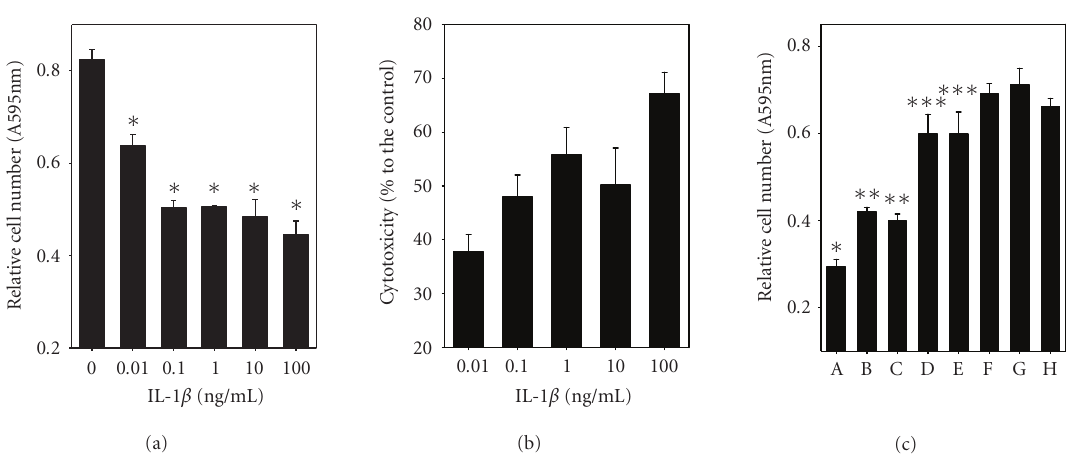
Figure 1: IL-1 inhibition of JAR proliferation. (a) JAR cells were cultured in the presence of increasing concentrations of IL-1 for 72 hours. Relative cell numbers were measured by MTT assay. (b) LDH release assay was performed for cytotoxicity of IL-1. (c) JAR trophoblasts were cultured for 72 hours with either IL-1 (50ng/mL) alone (A), IL-1 with anti- IL-1 antibody (5 μ g/mL) (B), IL-1 with anti- IL-1 anti- body (10 μ g/mL) (C), IL-1 with IL-1Ra (50ng/mL) (D), IL-1 with IL-1Ra (100ng/mL) (E), IL-1Ra (100ng/mL) (F), anti- IL-1 antibody (10 μ g/mL) (G), or untreated control (H). The MTT assay was then performed. The asterisks ( ∗ , ∗∗ , ∗∗∗ P < . 05) represent significant di ff erences between treatment and control groups as analyzed by One-Way